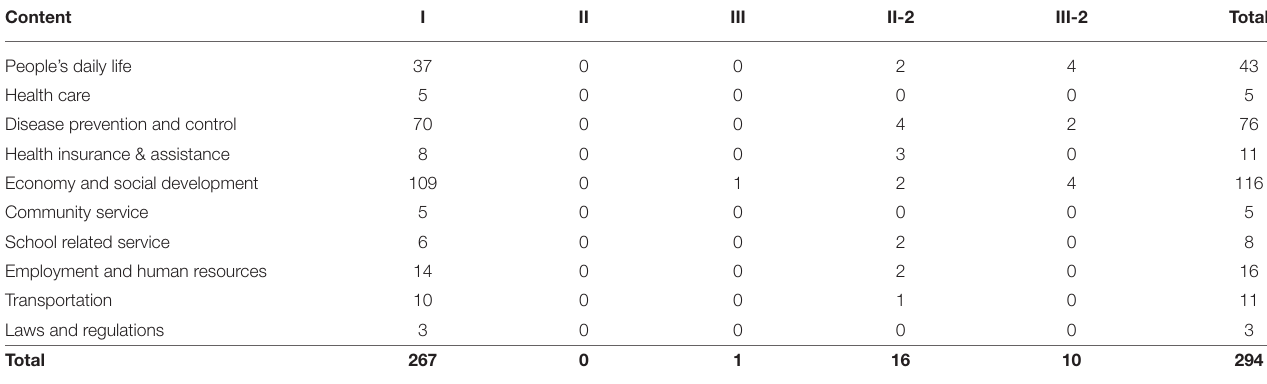
TABLE 3 | Contents of policy documents of Beijing municipal government website during the stages of the 2020 COVID-19